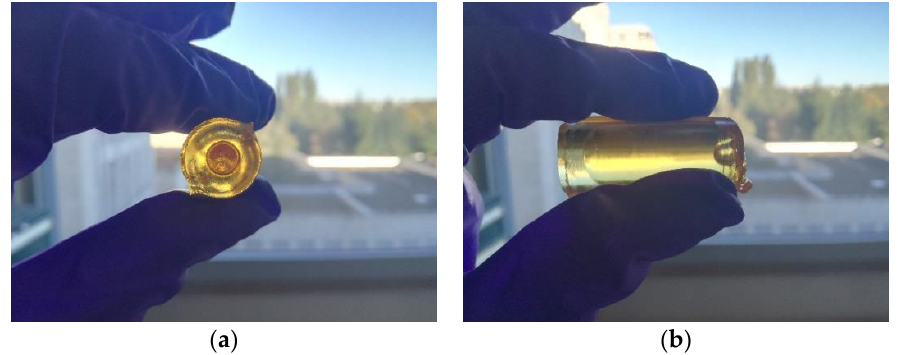
Figure 1. Pictures of the cross-section ( a ) and side-section ( b ) of the step-index preform synthetized with the built-in-casting method.